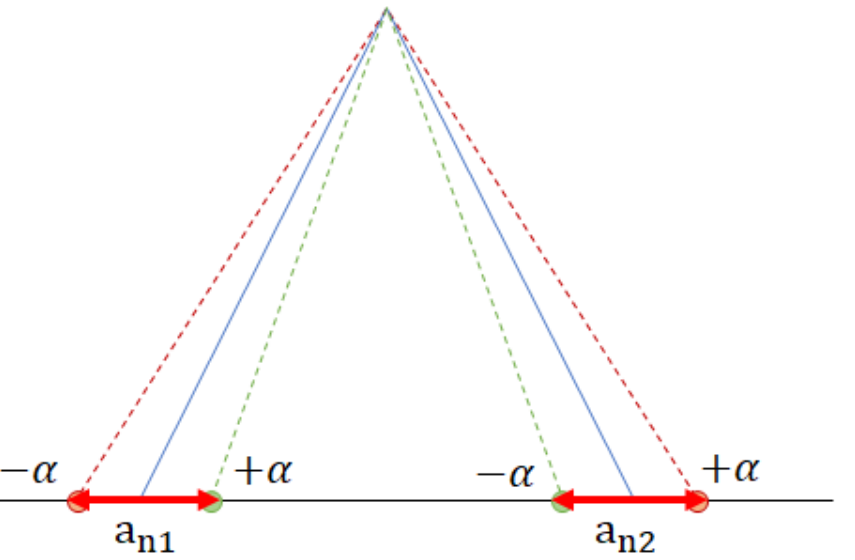
Figure 5. Variable assignment process of IGs generated in the output space for the generation of rational IGs.